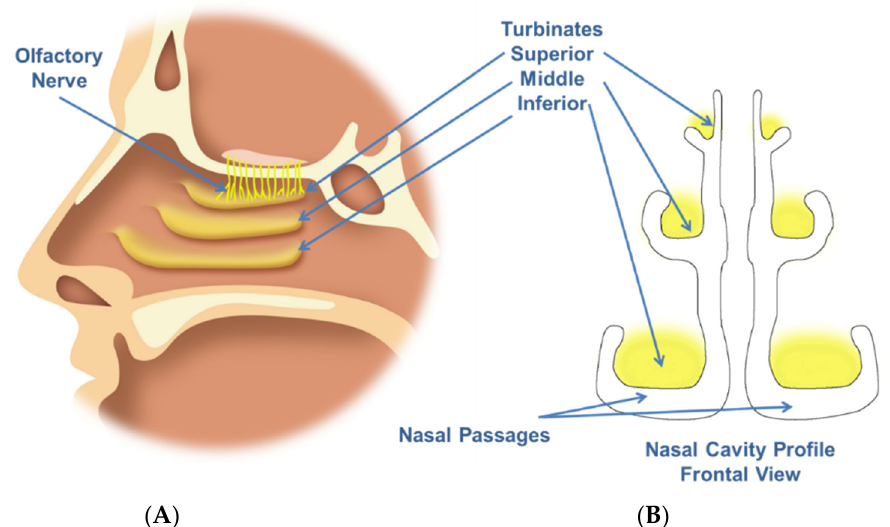
Figure 1. ( A ) Nasal cavity contains three turbinates that increase the surface area for warming and humidification of incoming air. Olfactory neurons innervate the superior nasal cavity. The turbi- nates and olfactory regions are nasal drug delivery targets. ( B ) The nasal passages are narrow and convoluted due to the turbinate structure. The complex structure and changing airflow through the nasal cavity may prevent deposition in the target